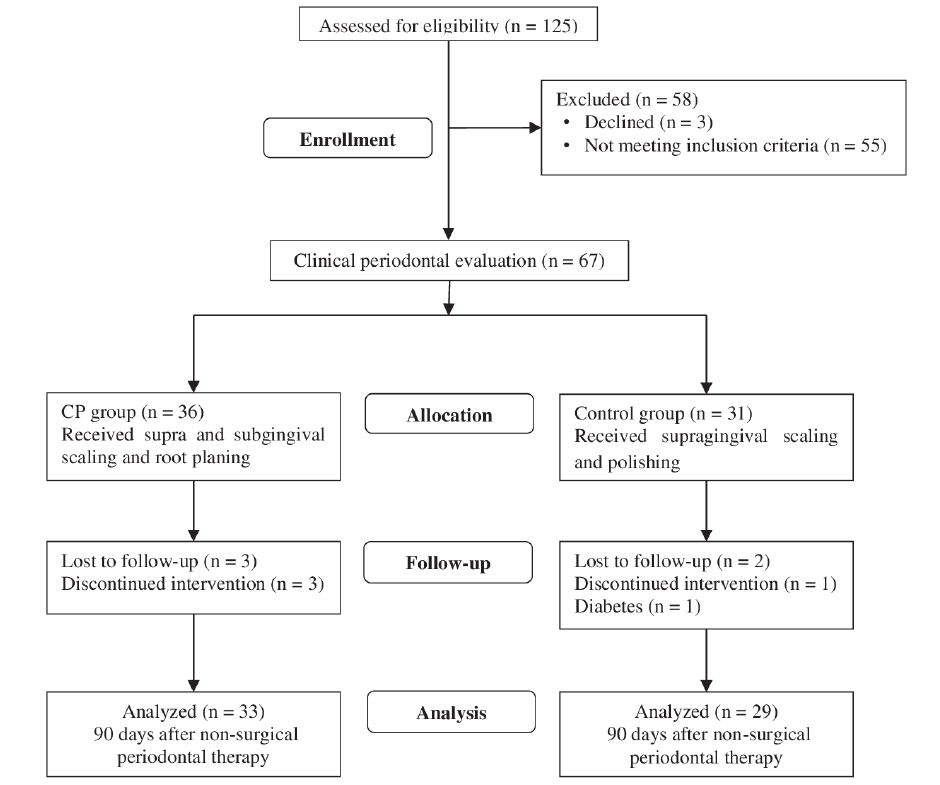
Figure 1 - Flowchart of study